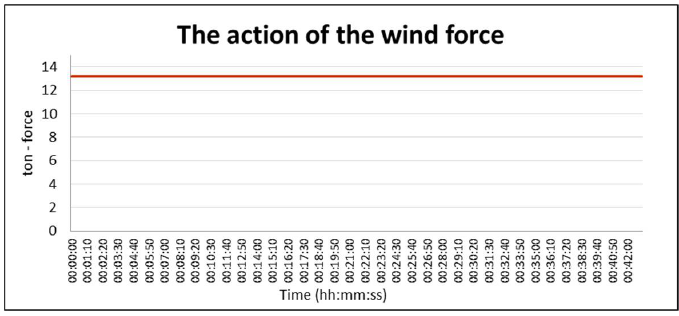
Figure 20. The force of wind pressure on the vessel’s hull for constant parameters of the weather zone (1 ton force = 9.80665 kN in SI system).